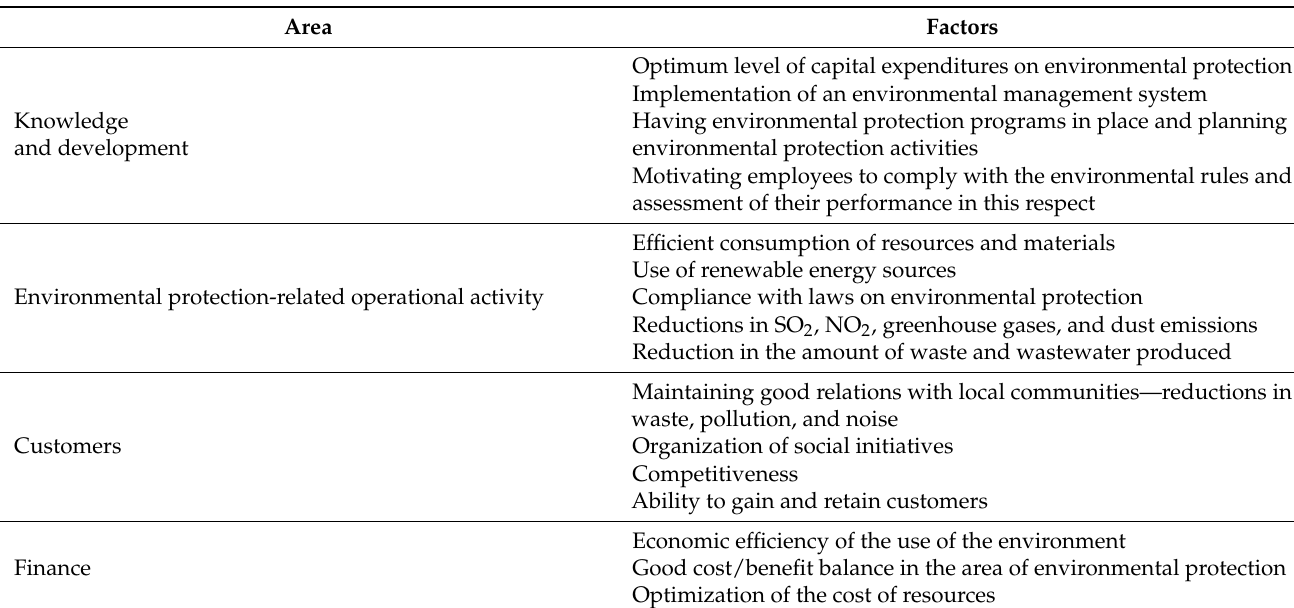
Table 1. Areas and factors of pro-environmental activity; own work based on